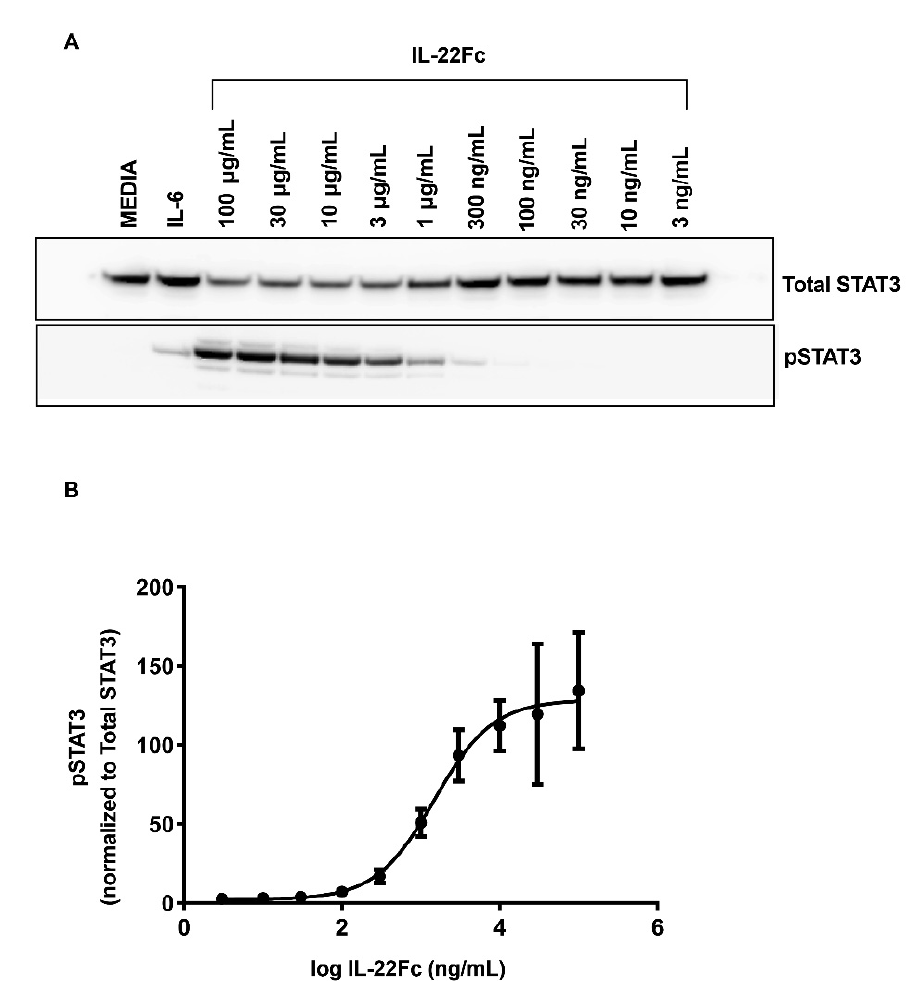
Figure 1. IL-22-mediated STAT3 activation, as measured in HT-29 cells. The HT-29 cells were cultured for 5 days with media, followed by an additional 18 h in serum-free media. Varying concentrations of IL-22 or 25 ng/mL rhIL-6 were added to the cell cultures for 20 min. The cell lysates were analyzed by Western blot. ( A ) Representative Western blot densitometry showing the pSTAT3 and total STAT3. ( B ) Levels of pSTAT3 normalized to STAT3, shown as the mean ± SD of three biological replicates. The EC 50 is 1.56 µg/mL.